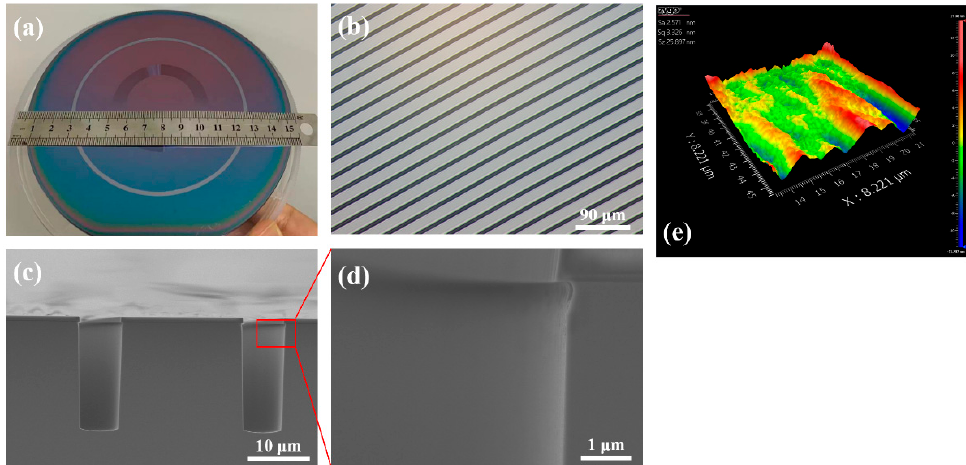
Figure 8. The images of final spiral trench sample: ( a ) picture of the entire sample, ( b ) surface morphology of MOG spiral trenches, ( c ) SEM image of trench profile, ( d ) partial magnification of the sidewall, and ( e ) roughness image of the sidewall.